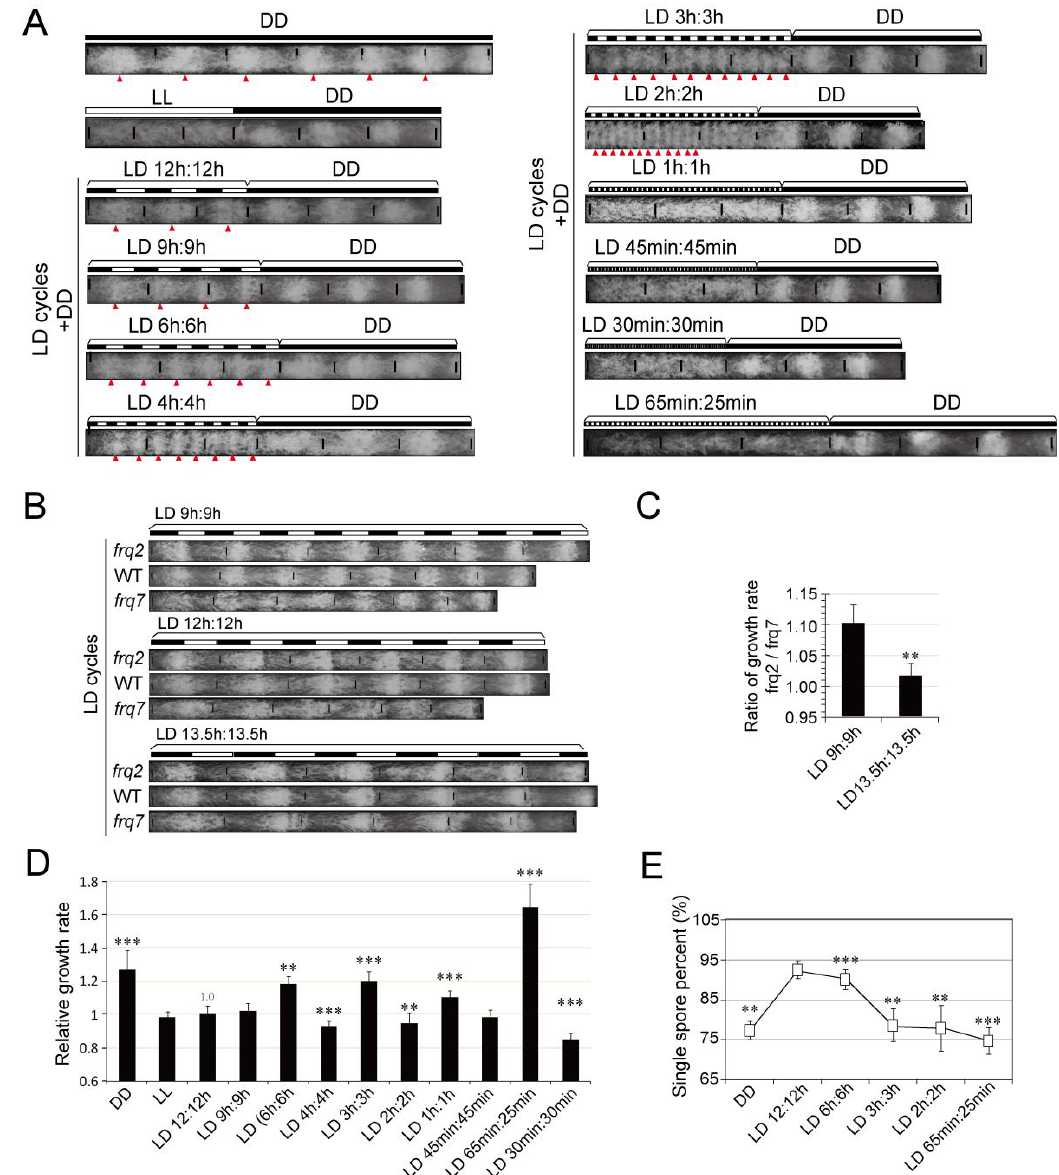
Figure 1. Conidiation rhythms, growth, and adaptation of Neurospora in short LD cycles. ( A ) Conidiation rhythms of Neurospora under a series of LD cycles. The black and white bars denote different LD regimes. Triangles denote the conidiation bands, ( B ) growth of Neurospora strains in race tubes under a series of LD cycles. Data are mean ± SD, n = 3. Representative results are shown ( n ≥ 3), ( C ) ratio of the growth rates between frq 2 and frq 7 calculated according to the results of ( B ). Data are mean ± SD, n = 3, ( D ) relative growth rate of WT strain calculated according to the results of ( B ). The daily growth lengths were normalized to the data in LD12:12. Data are mean ± SE, n = 3, ( E ) proportion of microconidia produced under different LD cycles. Data are mean ± SE, n = 3. The light intensity was 5000 lux. ** represents p ≤ 0.01 and *** represents p ≤ 0.001.